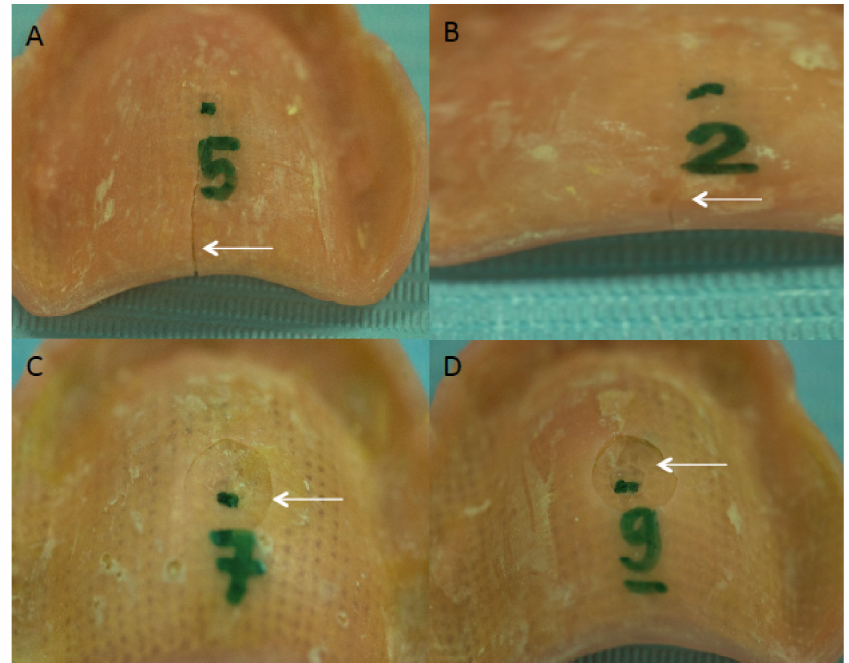
Figure 3. Fracture patterns of the PMMA resin plate samples in the study groups. ( A , B ), Showing straight line intact fracture patterns in Group 1 specimens. ( C , D ), Fractured specimens showing ditched fractures in specimens of Group 2 and Group 3,